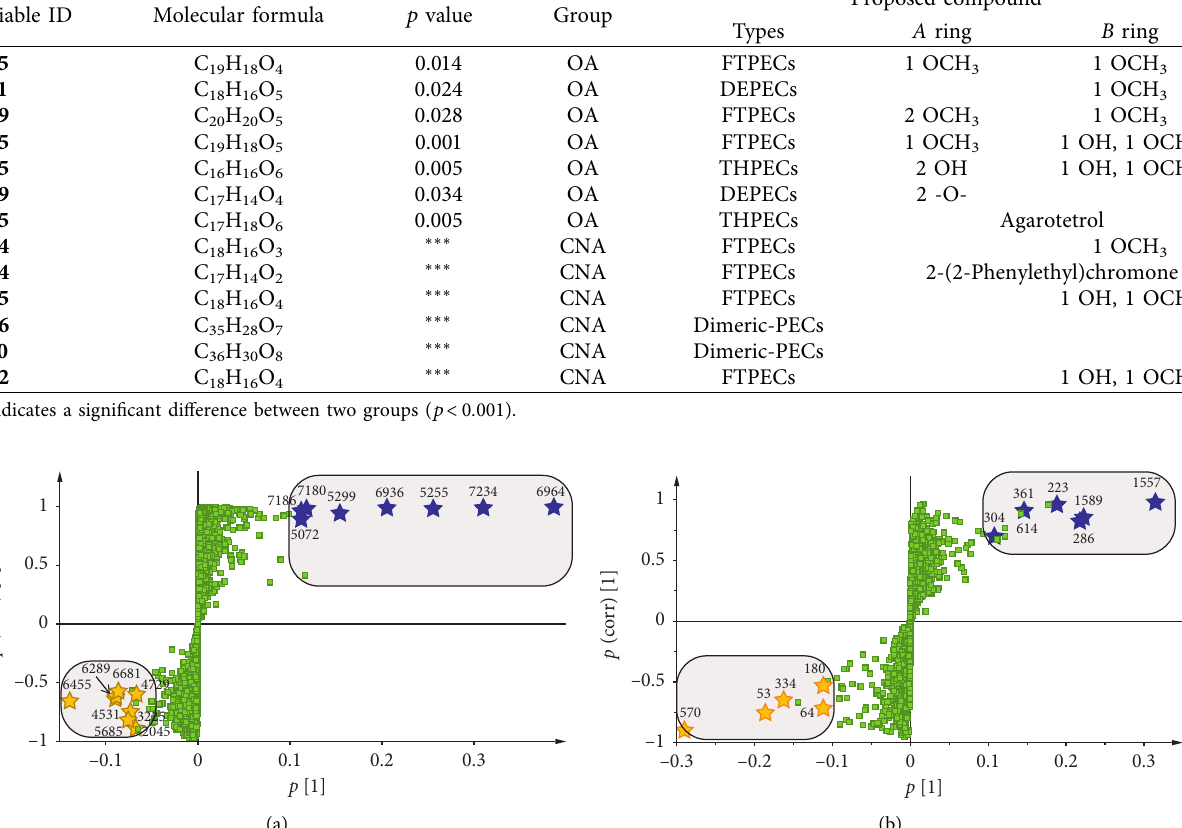
Table 2: Thirteen distinguished compounds between CNA and OA in terms of 2-(2-phenylethyl)chromones. Variable ID